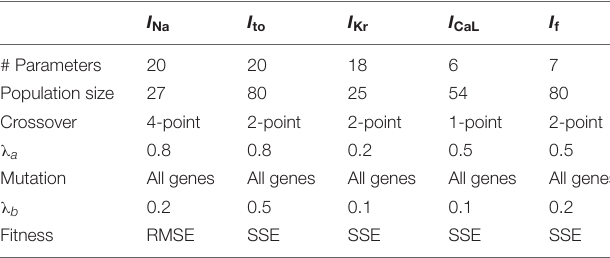
TABLE 2 | Summary of the genetic algorithm protocols for ionic